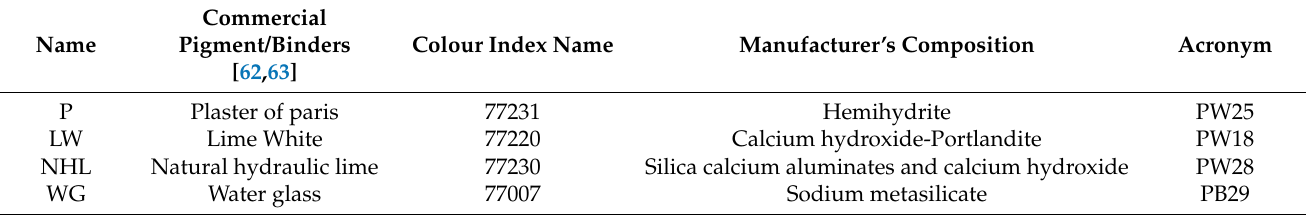
Table 2. List of raw materials used for binders along with an indication of the identification used in the study carried out, trade name, color index, composition and acronym.